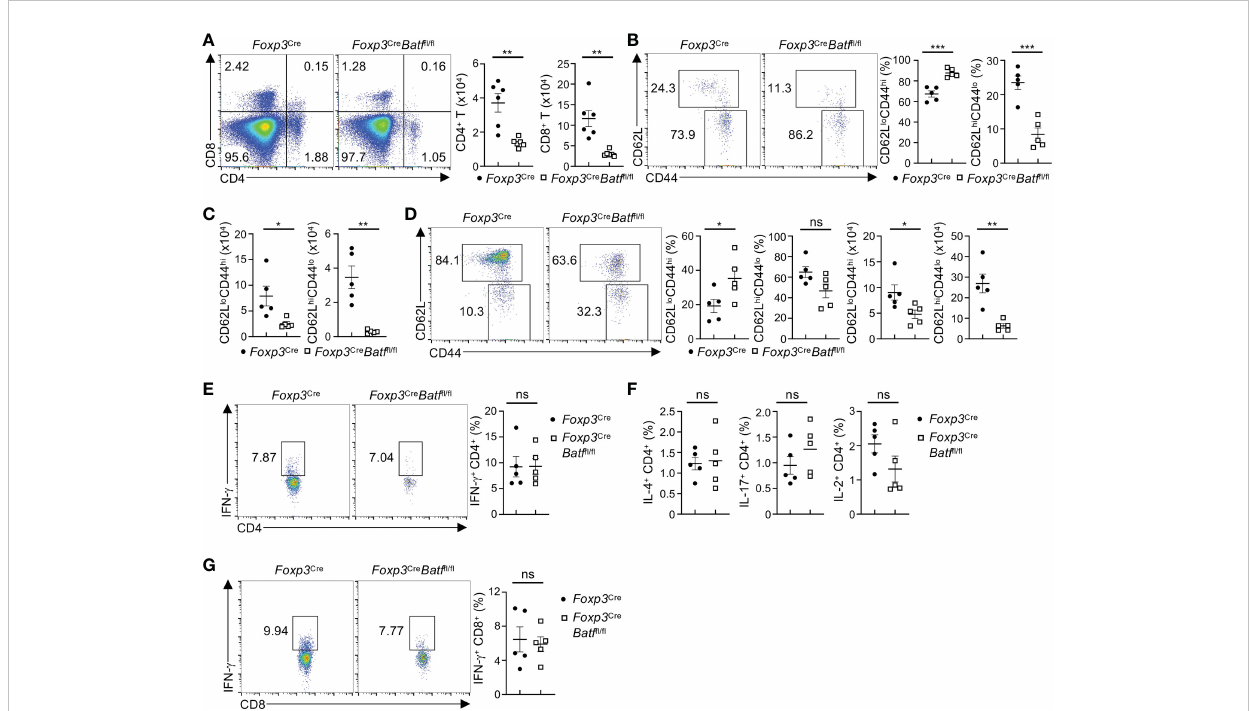
FIGURE 3 Foxp3 Cre Batf fl / fl mice have reduced proportions of T cells in the BM. (A) Flow cytometry analysis of CD4 + and CD8 + T cells in the BM of Foxp3 Cre and Foxp3 Cre Batf fl / fl mice. Right, numbers of CD4 + and CD8 + T cells in the BM ( n = 6 per group). (B) Flow cytometry analysis of CD62L and CD44 expression on conventional CD4 + T cells in the BM from Foxp3 Cre and Foxp3 Cre Batf fl / fl mice. Frequencies of CD62L lo CD44 hi (middle) and CD62L hi CD44 lo (right) in the BM ( n = 5 per group). (C) Numbers of CD62L lo CD44 hi and CD62L hi CD44 lo CD4 + T cells in the BM in (B, D) Flow cytometric analysis of CD62L and CD44 expression on BM CD8 + T cells from Foxp3 Cre and Foxp3 Cre Batf fl / fl mice. Frequencies (left) and numbers (right) of CD62L lo CD44 hi and CD62L hi CD44 lo CD8 + T cells in the BM ( n = 5 per group). (E) Flow cytometric analysis of IFN- g production by CD4 + T cells in the BM from Foxp3 Cre and Foxp3 Cre Batf fl / fl mice. Right, frequencies of IFN- g -producing CD4 + T cells ( n = 5 per group). (F) Frequencies of BM CD4 + T cells producing IL-4 (left), IL-17 (middle), and IL-2 (right) from Foxp3 Cre and Foxp3 Cre Batf fl / fl mice ( n = 5 per group). (G) Flow cytometry analysis of IFN- g production by BM CD8 + T cells from Foxp3 Cre and Foxp3 Cre Batf fl / fl mice. Right, frequencies of IFN- g -producing CD8 + T cells ( n =